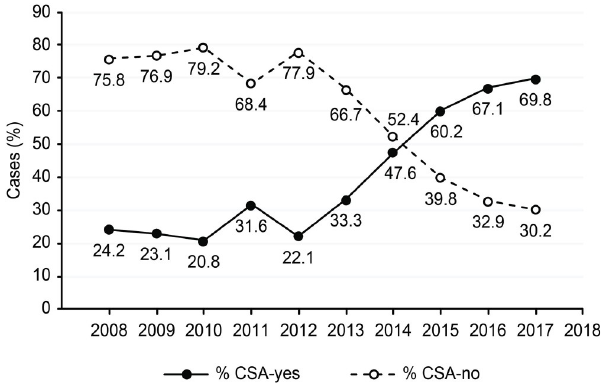
Fig 3. Percent of thyroid cancer patients in the CSA-yes and CSA-no groups from 2008–2017.